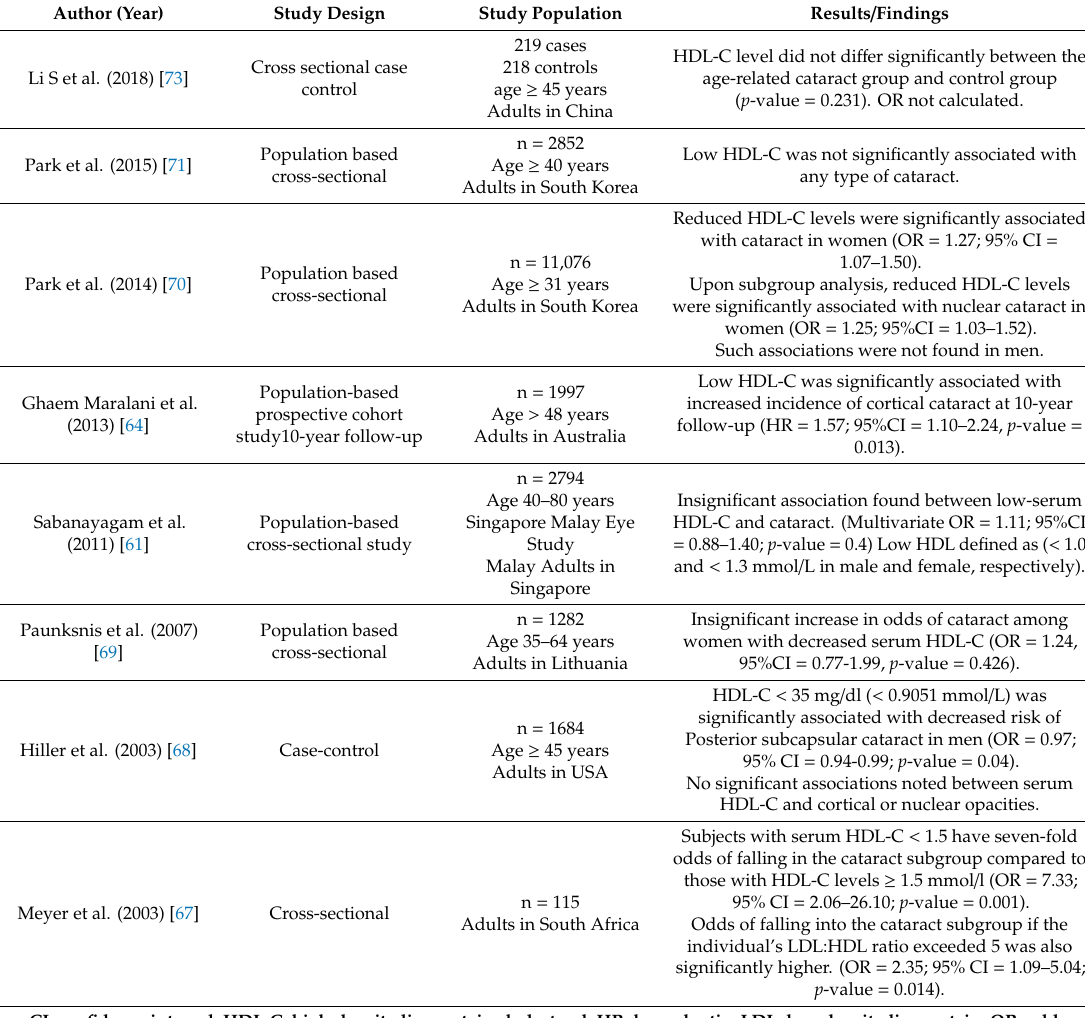
HDL-C and Age-Related Cataracts—Epidemiological Links from Observational Studies